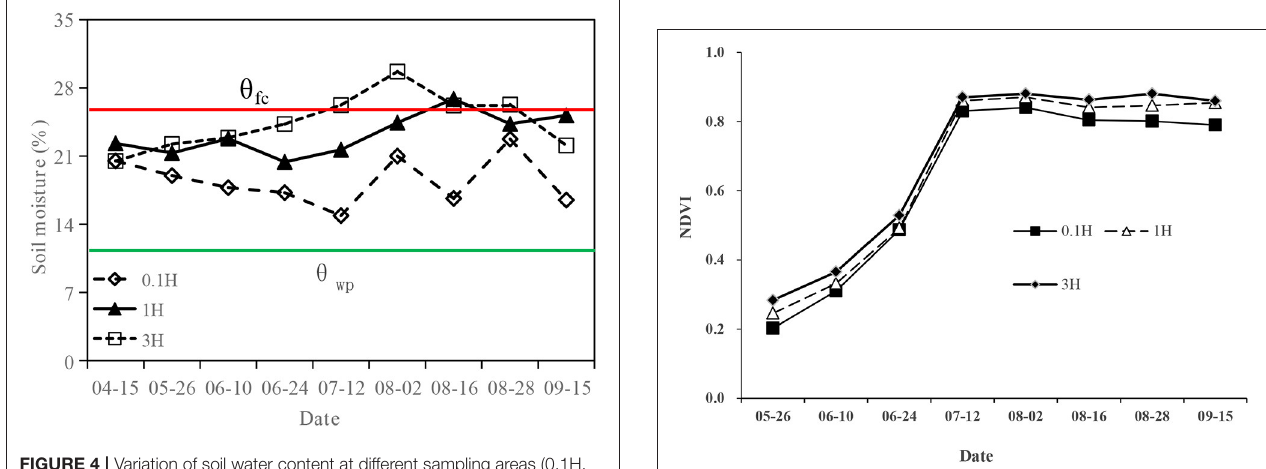
FIGURE 4 | Variation of soil water content at different sampling areas (0.1H, 1H, and 3H).